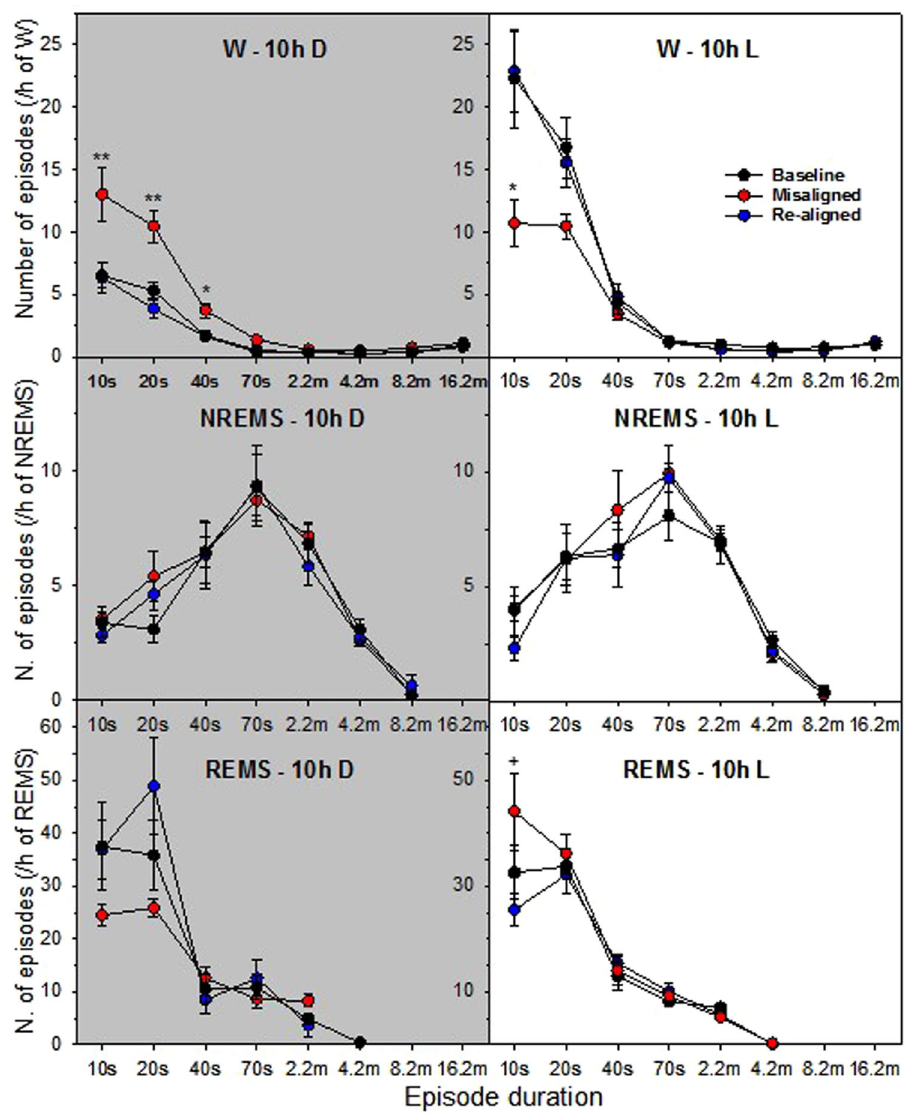
Figure 3. Frequency distribution of episodes of wakefulness (W), NREM sleep (NREMS) and REM sleep (REMS) throughout eight consecutive time bins (10, 20–30, 40–60, 70–120, 130–240, 250–480, 490–960 and ≥ 970 s) for the 10-h light and 10-h dark periods of the T20 cycles. Values are potted against the lower limit of each bin. Circle symbols (same colour codes as Fig. 2) represent the mean number of W, NREM sleep and REM sleep episodes ( ± SEM; B6: n = 5) per bin expressed per hour of its respective vigilance state (W, NREMS and REMS). Time bin with a significant effect of T20 cycle (repeated measures ANOVA, P < 0.05) were followed by Tukey post-hoc tests (between the three T20 cycles): Asterisks ( * P < 0.05; ** P < 0.01) indicate that the misaligned T20 cycle is different from both baseline and re-aligned T20 cycles; plus symbol ( + P < 0.05), misaligned T20 cycle higher than re-aligned T20